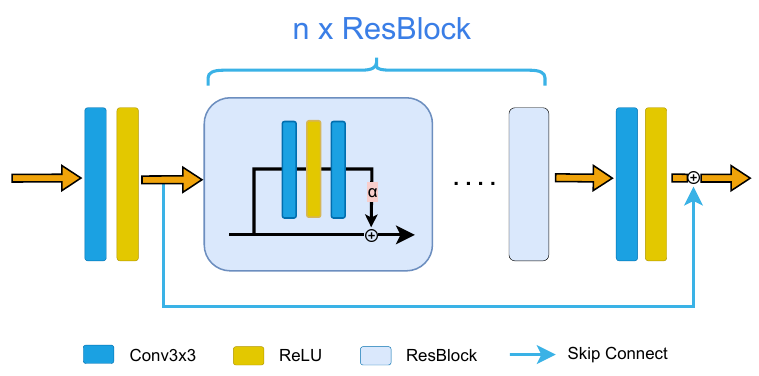
Figure 4. The structure of the encoder network.